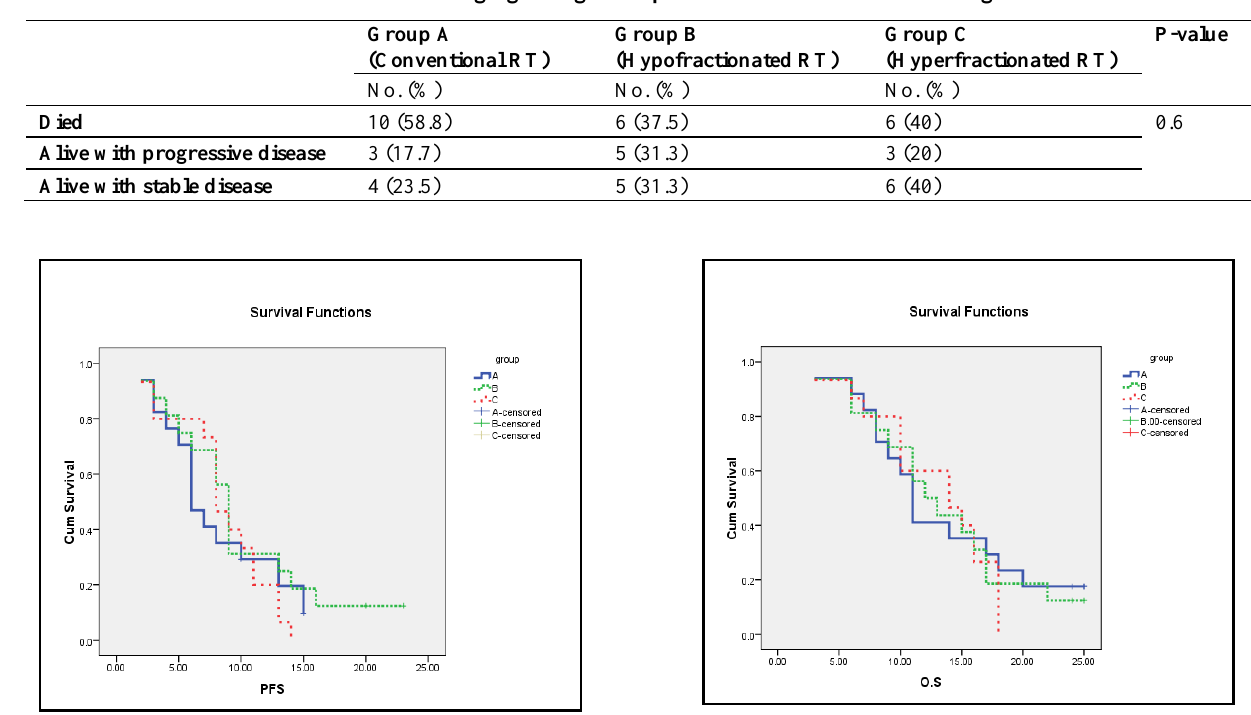
Table 3: Survival and disease status of high grade glioma patients at 12 months according to fractionation schedule